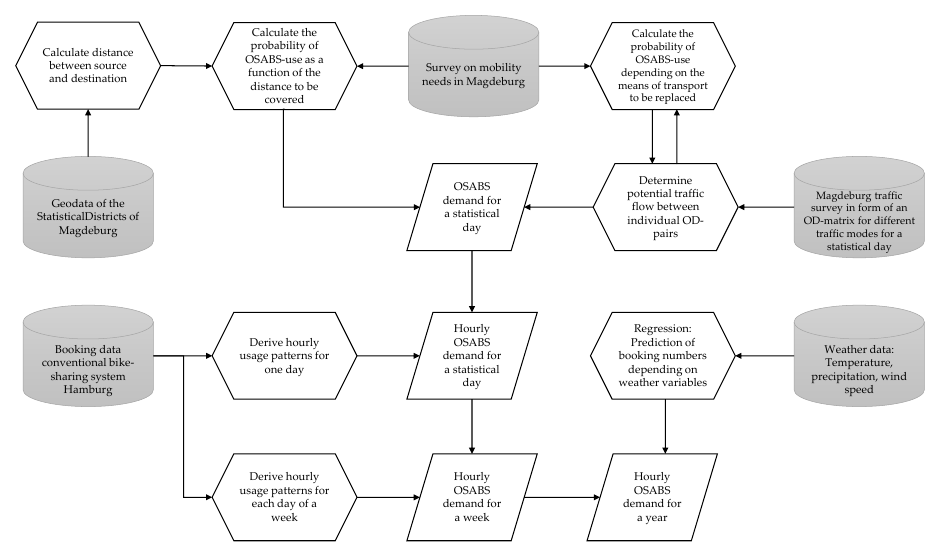
Figure 2. Proceeding for the creation of the demand scenario.